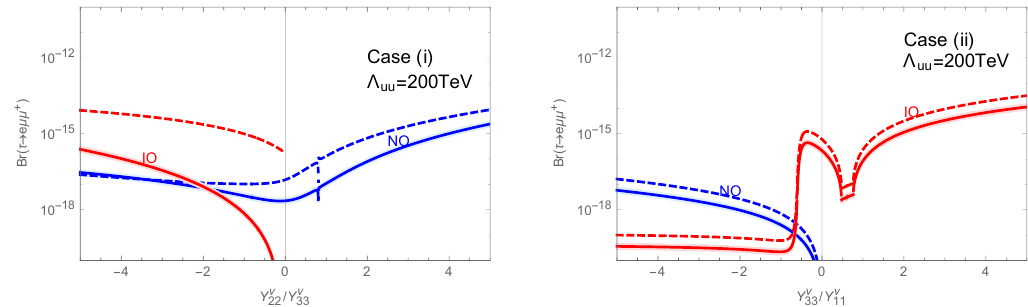
; Y (cid:23) ; M (cid:0) 1 ) = (0 : 01 ; 1 ; 0) on the right 11 22 (cid:23) 2